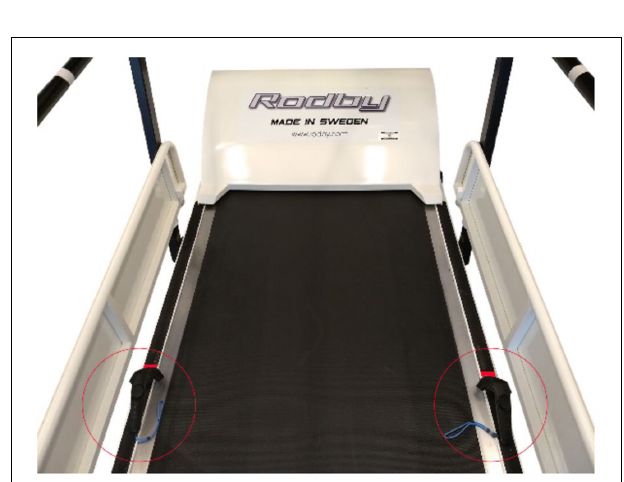
FIGURE 4 | During calibration process, the hand controllers are physically placed on the treadmill as illustrated.